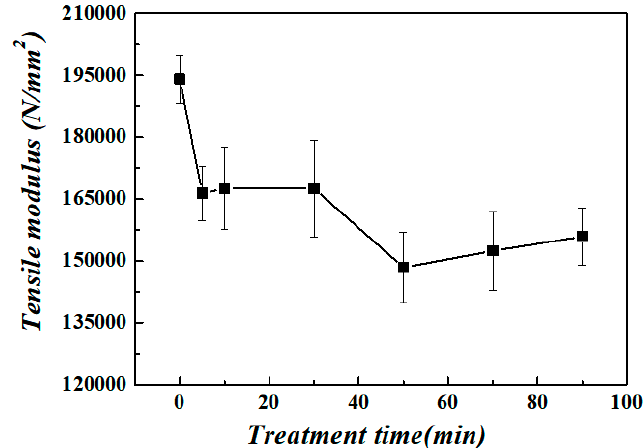
Figure 11. Effect of the acid treatment time on the tensile modulus of stainless-steel fiber.